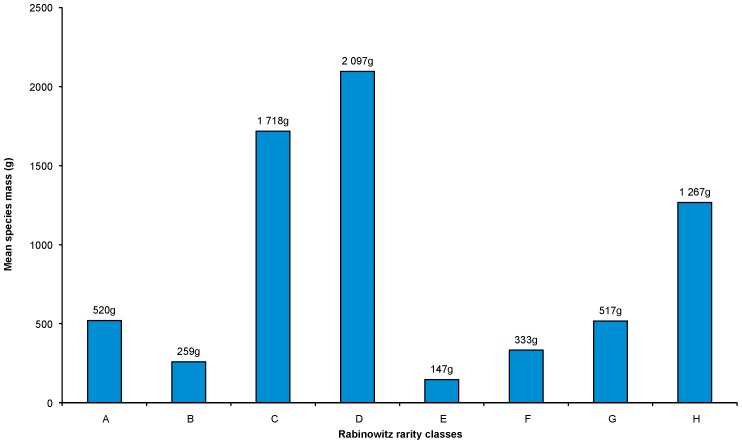
Mean mass (g) of bird species sold for traditional medicine within each of the eight Rabinowitz rarity classes.